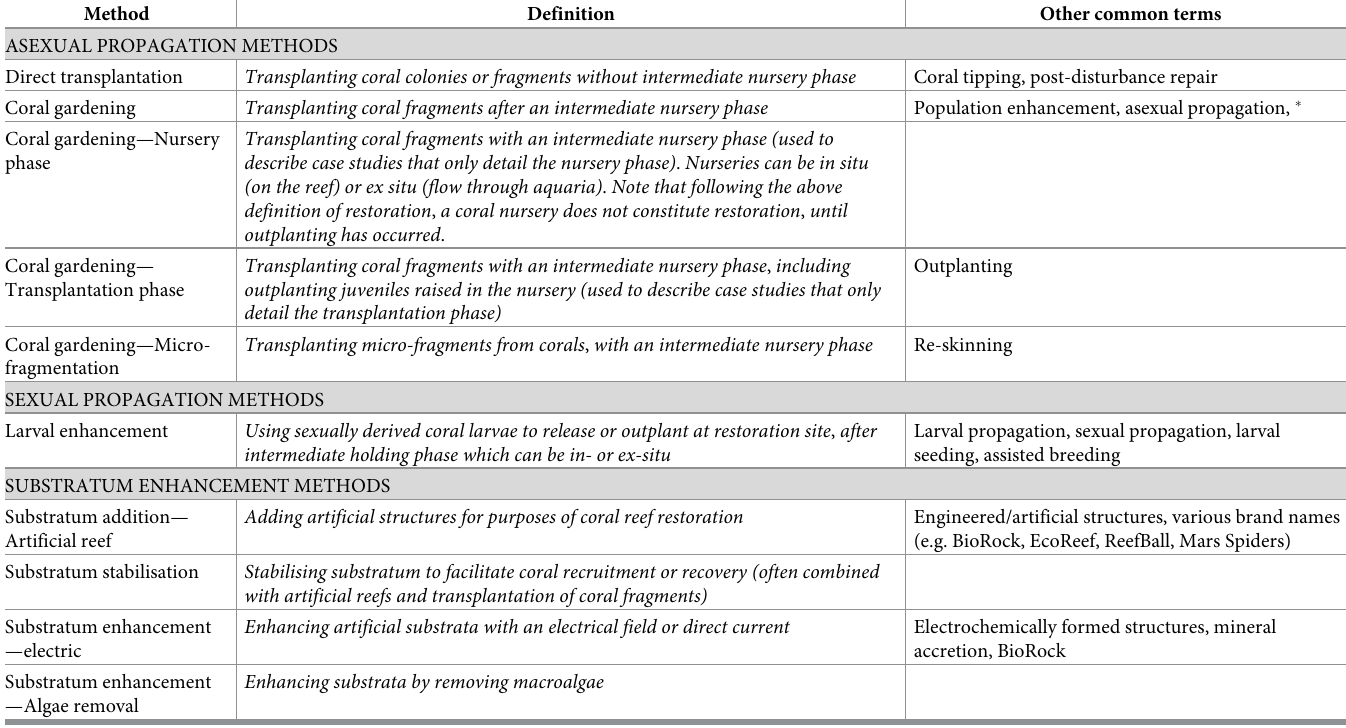
Table 1. The terms for restoration methods used in the review, their definitions and other common terms. Categories are not mutually exclusive as some methods are often combined.